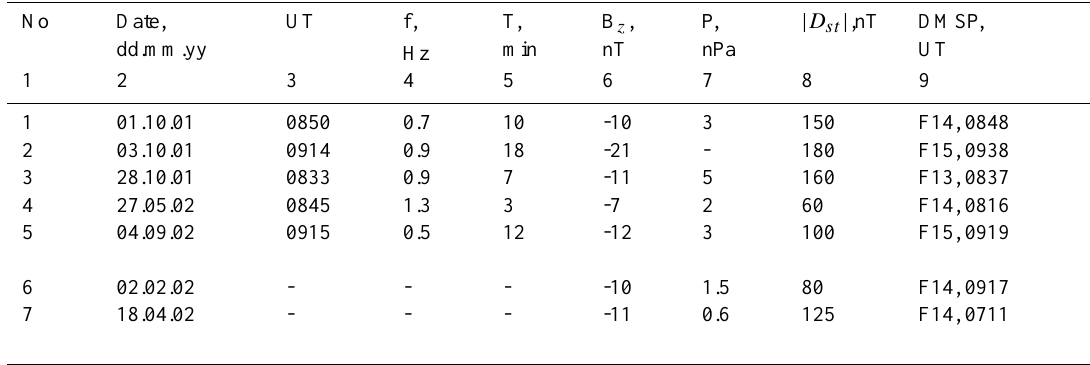
Table 1. Characteristics of intervals when BAB was inside the polar